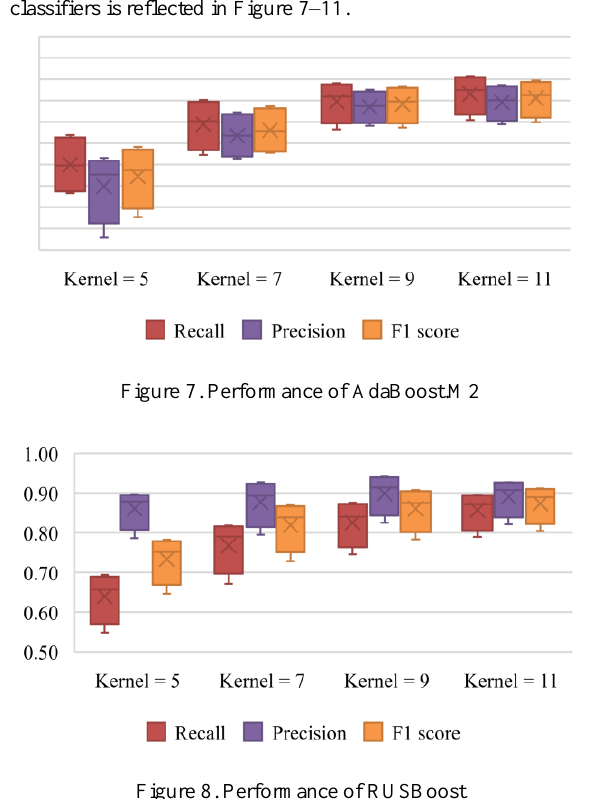
Figure 8. Performance of RUSBoost